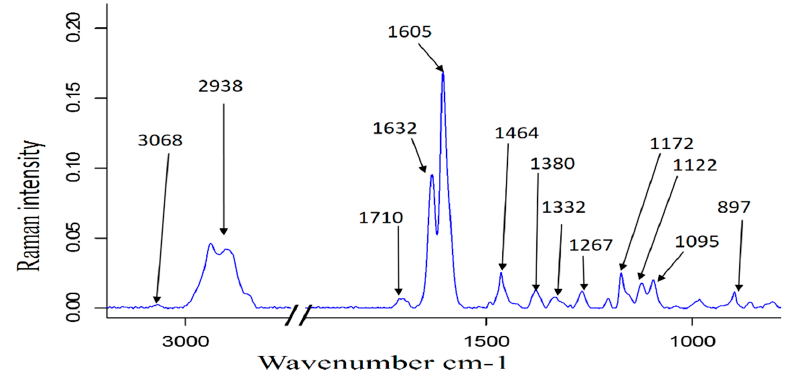
Figure 1. Raman spectrum of native Typha capensis .